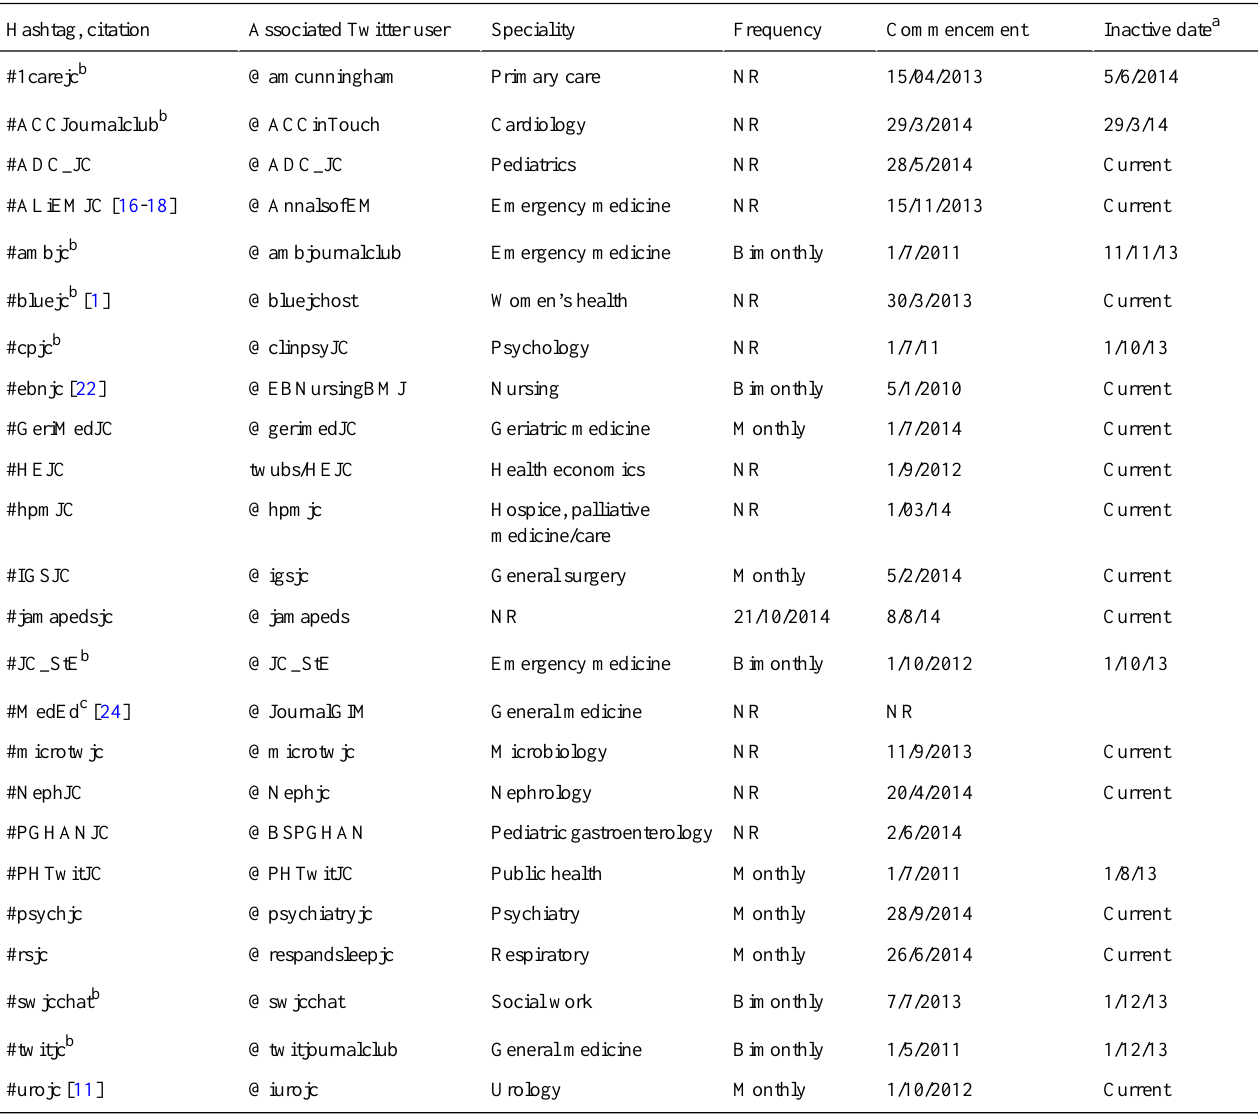
Table 1. Demographic information for Twitter-based journal clubs, including specialty, frequency, commencement, inactive status, and associated peer-reviewed